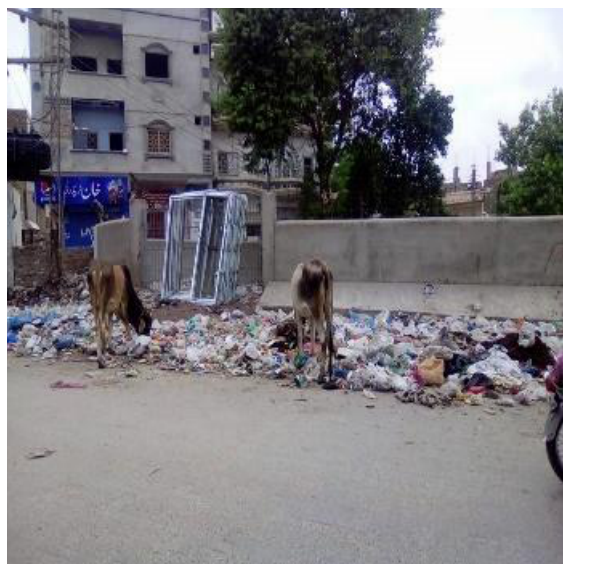
FIG. 2. AIRPORT ROAD,